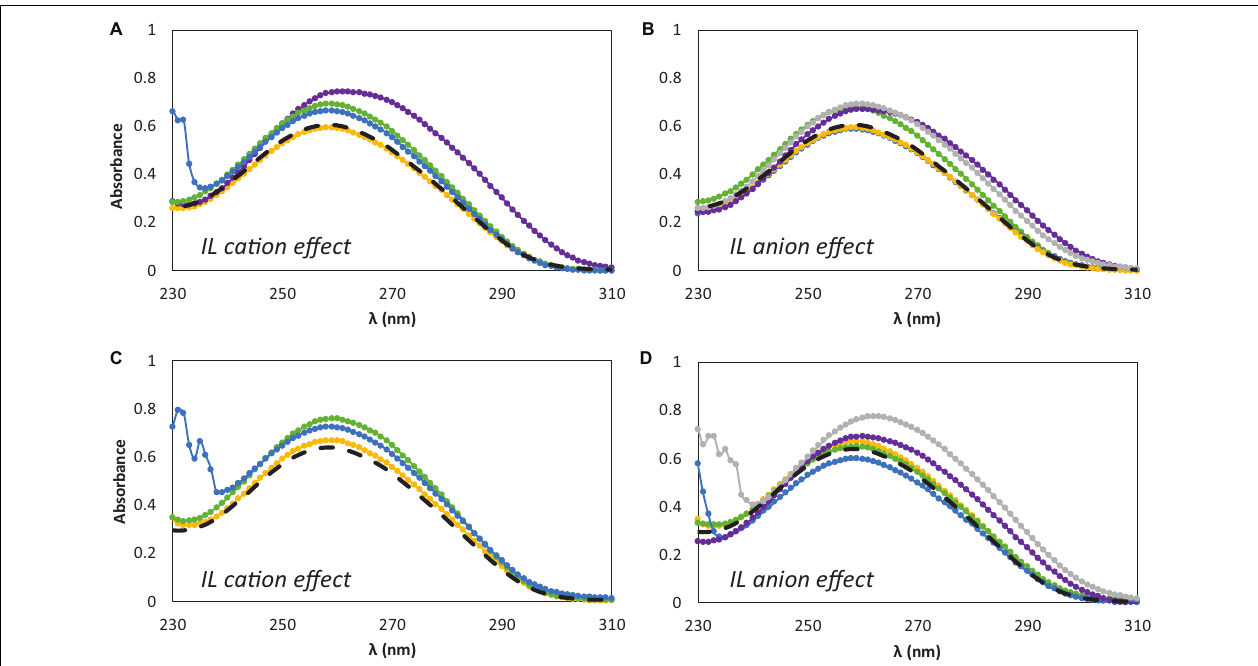
FIGURE 5 | Absorption spectra of β -DNA (from salmon testes) as a function of wavelength, λ , in 10 mM of Tris–HCl buffer (pH ≈ 7.2) aqueous solutions at different concentrations of IL. (A) 5 wt% of bromide-based ILs: ( — ) only buffer; ( • ) [N 111 ( 2 OH ) ]Br; ( • ) [C 2 C 1 im]Br; ( • ) [N 4444 ]Br; ( • ) [P 4444 ]Br; (B) 5 wt% of cholinium-based ILs. ( — ) only buffer; ( • ) [N 111 ( 2 OH ) ]Br; ( • ) [N 111 ( 2 OH ) ][Ac]; ( • ) non-buffered [N 111 ( 2 OH ) ][DHP]; ( • ) [N 111 ( 2 OH ) ]Cl; ( • ) [N 111 ( 2 OH ) ][Gly]; (C) 30 wt% of bromide-based ILs: ( — ) only buffer; ( • ) [N 111 ( 2 OH ) ]Br; ( • ) [C 2 C 1 im]Br; ( • ) [N 4444 ]Br; (D) 30 wt% of cholinium-based ILs. ( — ) only buffer; ( • ) [N 111 ( 2 OH ) ]Br; ( • ) [N 111 ( 2 OH ) ][Ac]; ( • ) non-buffered [N 111 ( 2 OH ) ][DHP]; ( • ) [N 111 ( 2 OH ) ]Cl; ( • ) [N 111 ( 2 OH ) ][Gly].